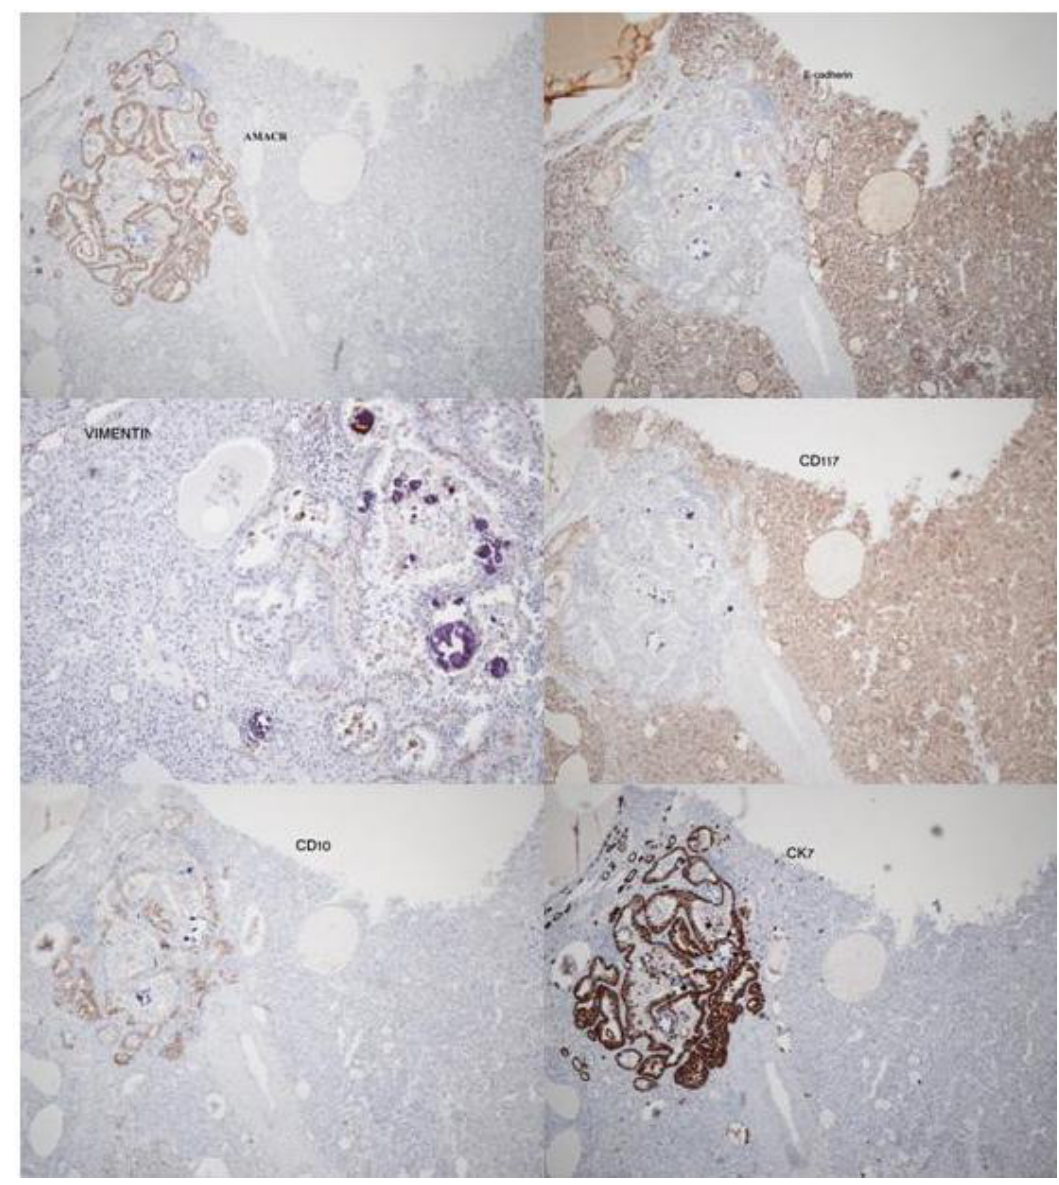
FIGURE 2. Immunohistochemical staining showing an oncocytoma positive for E-cadherin and CD117, but negative for CK7, CD10, and AMACR. The reverse was found in the papillary carcinoma. The exfoliated cells stained positive for